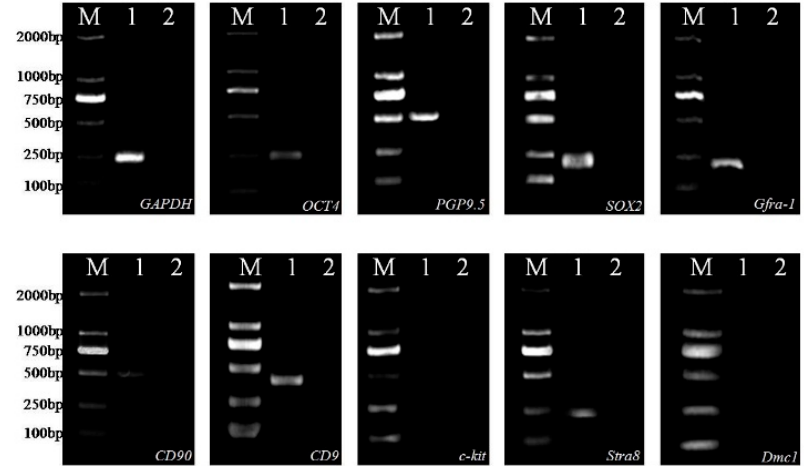
Figure 2. Expression of SSC-specific genes in cultured cells as determined by RT-PCR. M, DL2000 Marker used as a molecular size indicator; Lane 1, specific genes expression with cDNA of cultured cells; Lane 2, negative control with RNA of cultured cells; GAPDH used as positive control in cultured